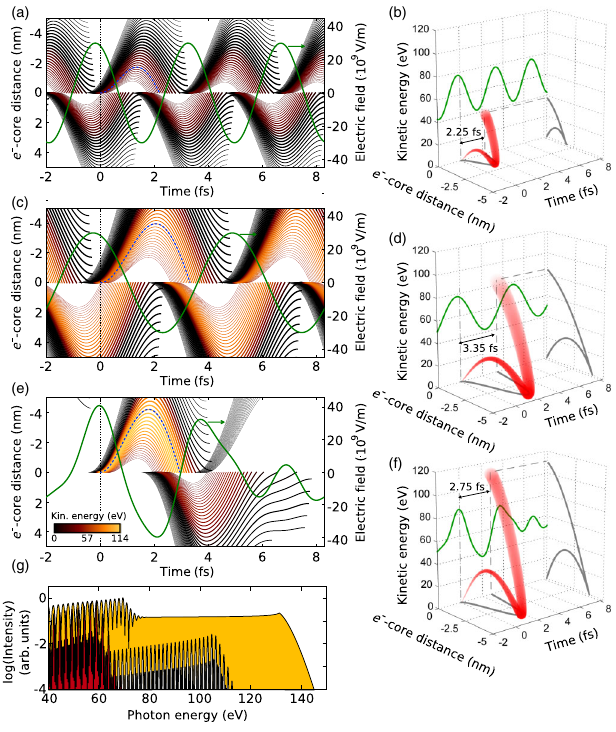
FIG. 1. (a) – (f) Classical electron trajectories, with driving electric field shown by the green line, (g) HHG spectra. Both single-color drivers [ 1 . 03 μ m (a),(b) and 1 . 545 μ m (c),(d)] have an intensity of 1 . 2 × 10 14 W cm − 2 . The three-color waveform [(e),(f), combination of 1.03, 0.515, and 1 . 545 μ m with relative intensities as in our experiments [Fig. 6(c)] and optimal phase delays (see also Ref. [24])] has the same fluence within its 10.3-fs period as the single-color waves. In (a), (c), and (e), the classical electron trajectories are colored according to their recollision energy [the color bar in (c) is also valid for (a) and (b), nonrecolliding trajectories are black]. A thicker line indicates a higher tunneling rate at the ionization instant (normalized in each panel). The cutoff trajectory with the highest recollision energy is marked by the dashed blue line, and its ionization instant, t ¼ 0 , is marked by the vertical dotted line. This cutoff trajectory is again shown in (b), (d), and (f) by points with radii that linearly increase with excursion time, symbolizing wave packet spread- ing. The more efficient acceleration in the three-color field is apparent. Panel (d) shows the corresponding single-atom HHG spectra (red for 1 . 03 μ m, white for 1 . 545 μ m, yellow for the three-color driver) calculated for the ionization potential of argon (15.76 eV) over a 10.3-fs time window and including the short-trajectory class only